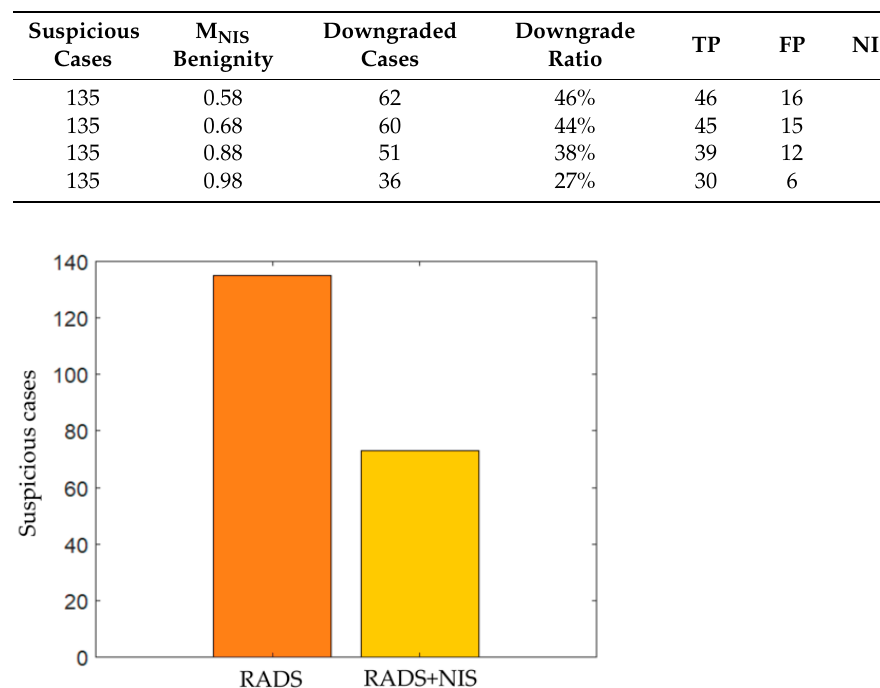
Figure 10. The number of suspicious cases decreased from 135 to 73 by combination Lung-RADS and M NIS scores on S v . The 62 downgraded cases would be considered as probably benign or Lung-RADS 3